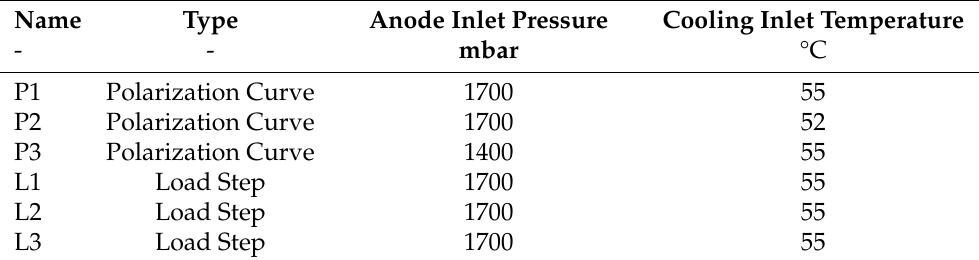
Table 1. Available measurement series from the test stand.